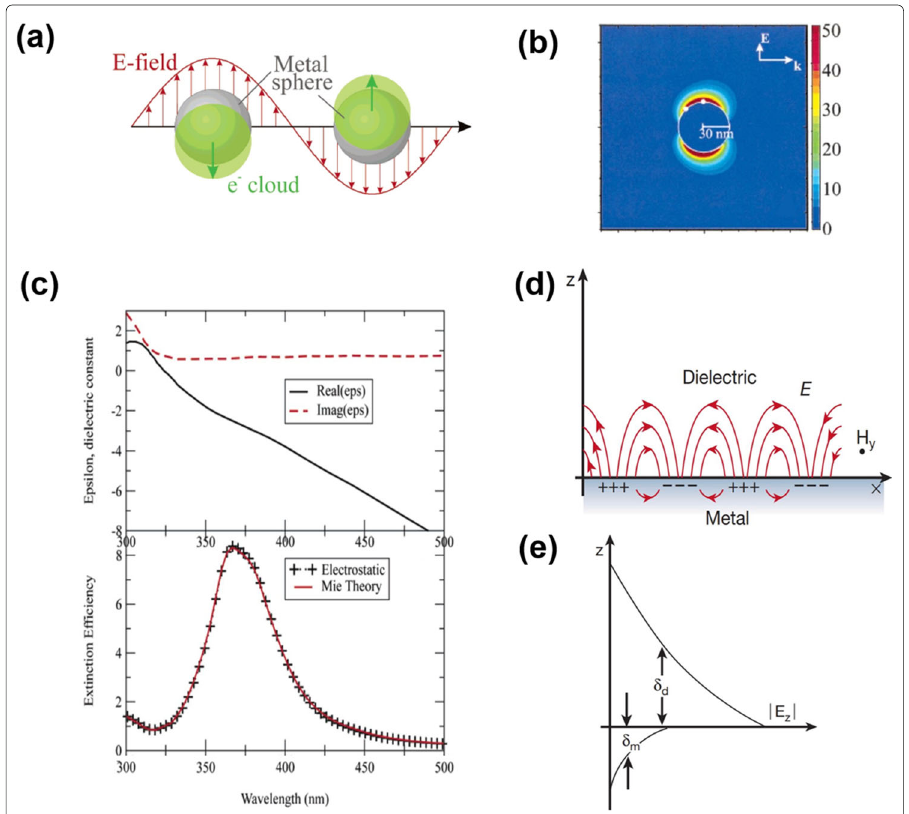
Fig. 6 SPP basics. a Schematic diagram of plasmon oscillation for a sphere [192]. b Electric field contours and c Extinction efficiency of dipole mode of a silver nanosphere with r = 30 nm [192]. d Schematic diagram